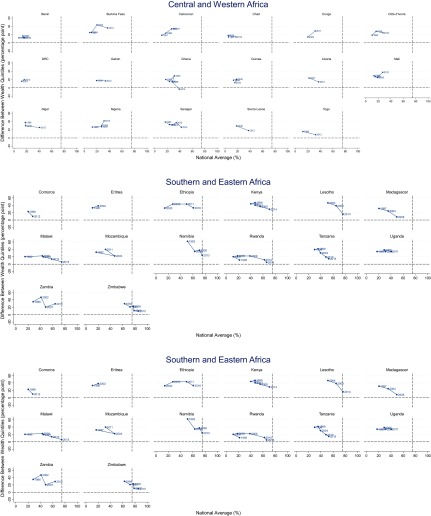
Trends in National-Level Family Planning Demand With Modern Methods (%) and Disparity by Wealtha (Percentage Point), by Region and Countrya Difference between the highest and lowest wealth quintiles.